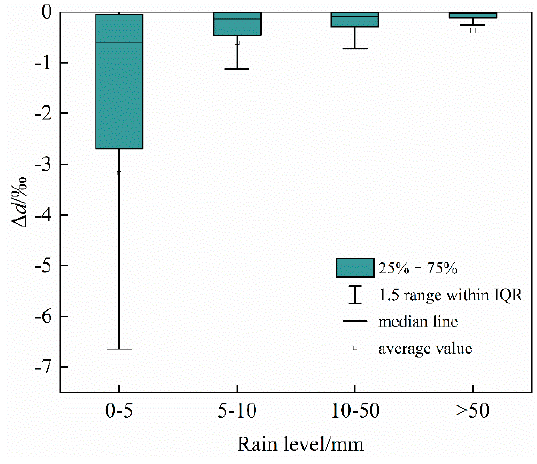
Figure 5. Δ d value of different rain levels. Figure 5. ∆ d value of different rain